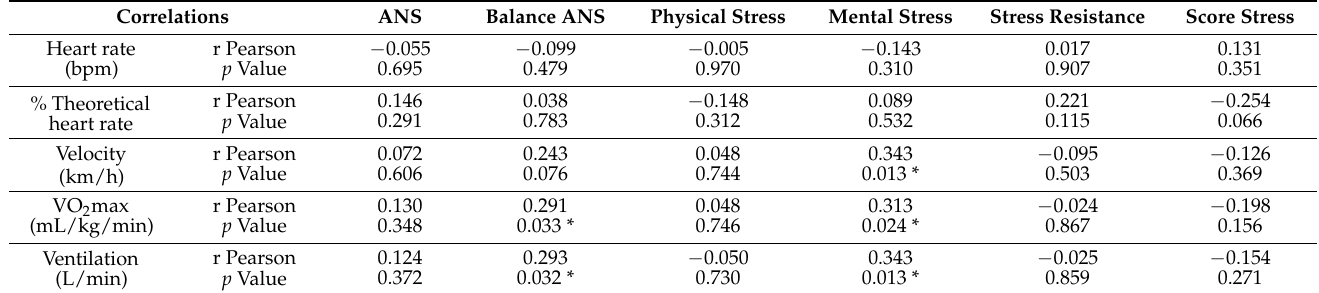
Table 6. Correlations between initial stress variables and differences after the ST.